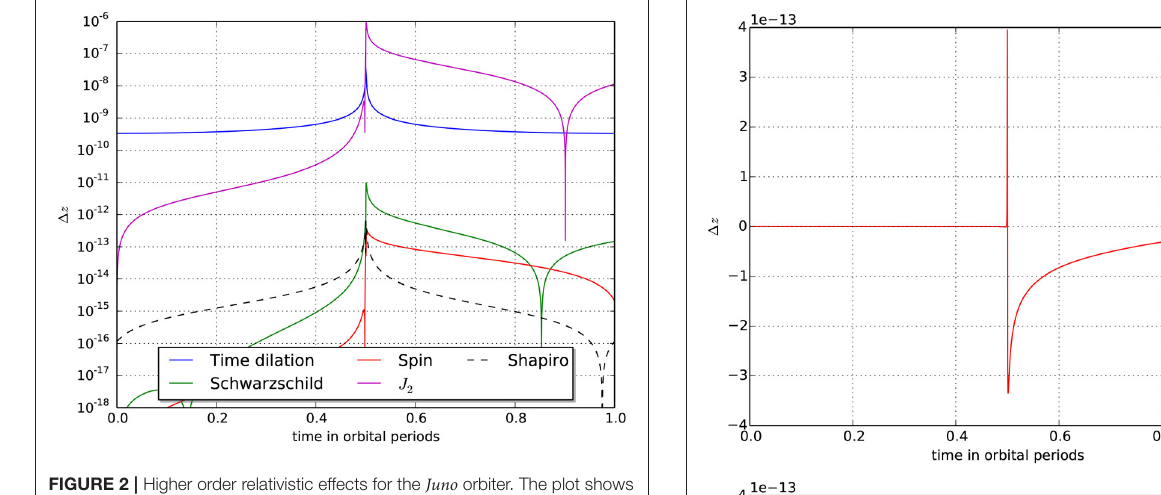
Cassini has a sensitivity that is about 1 z